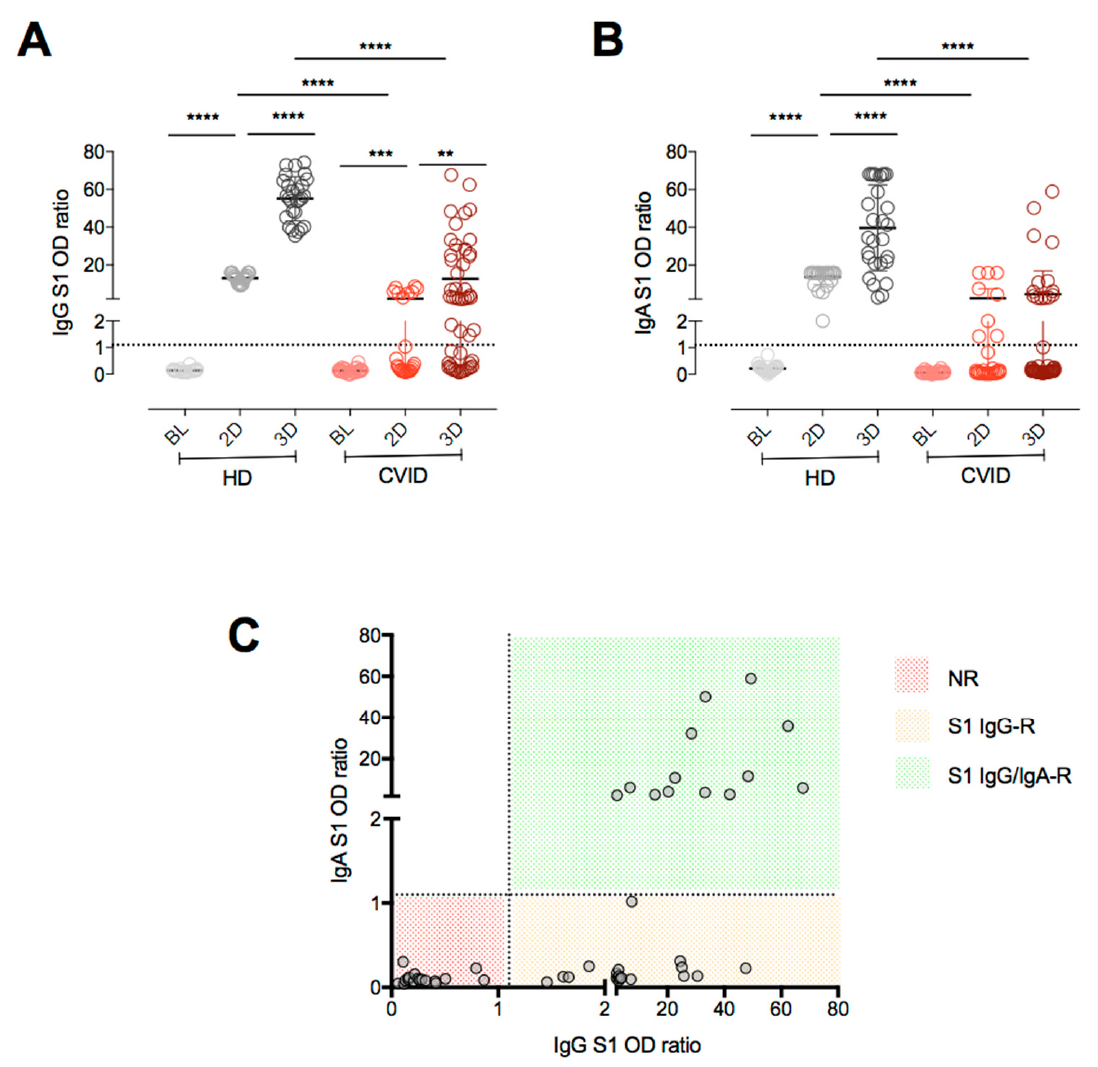
Figure 1. Anti-Spike S1 IgG ( A ) and IgA antibodies ( B ) in HD and CVID patients before and after full immunization with two doses (2D), and after the booster dose (3D) of mRNA BNT162b2 vaccine. Based on antibody responses after the booster dose, we identified three CVID groups ( C ): non responders (NR); anti-S1 IgG only responders (IgG-R), and anti-S1 IgG and anti-S1 IgA responders (IgG/IgA-R). Medians are plotted as horizontal bars and statistical significance were determined using two-tailed Mann–Whitney U-test or Wilcoxon matched-pairs signed-rank test. ** p < 0.01, *** p < 0.001; **** p < 0.0001. HD n = 26; CVID n = 47.